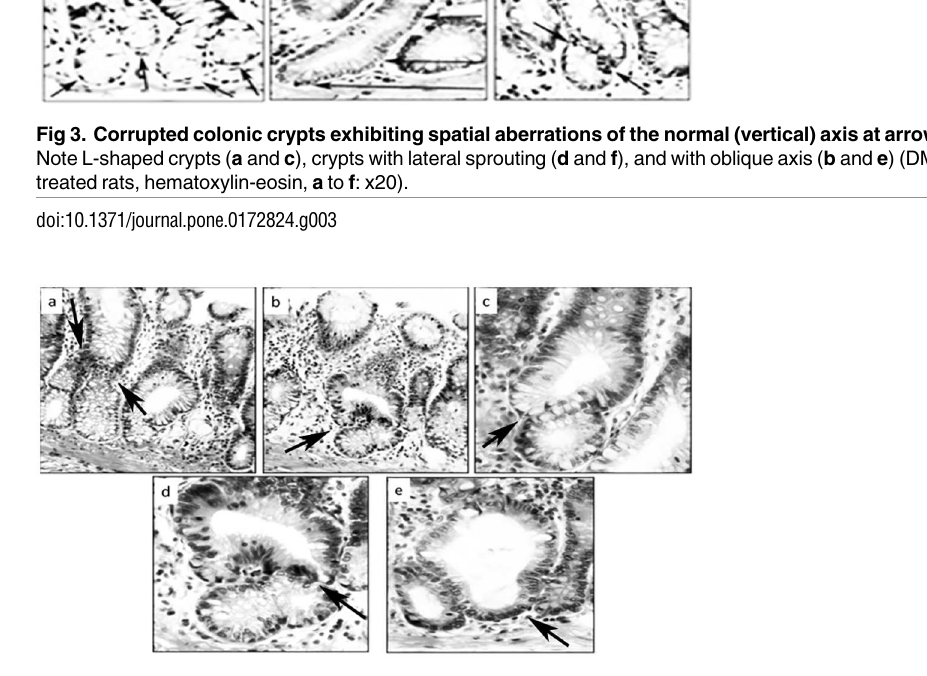
Fig 4. Corrupted colonic crypts showing various degrees of corrupted fission at arrows, some with abnormal basal crypt dilatation. Note low-gradedysplasia( b to e ; d : detail of figure b ). (DMH-treated rats, hematoxylin-eosin, a , b x20, c, d, e x40).